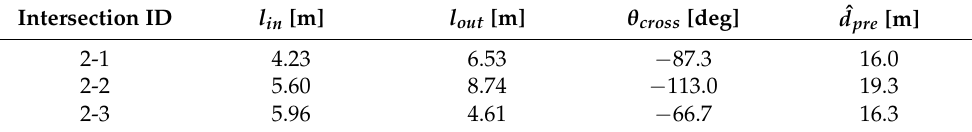
Table 3. Specifications of target intersections and estimated parameters.